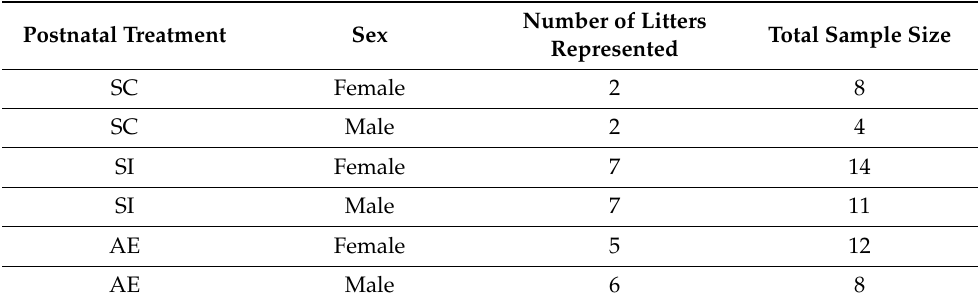
Table 1. Sample sizes for each postnatal treatment group in this study. SC: “suckle control” (typically- developing control group), SI: “sham-intubated” (procedural control group), AE: “alcohol-exposed” (5.25 g/kg/day) experimental treatment